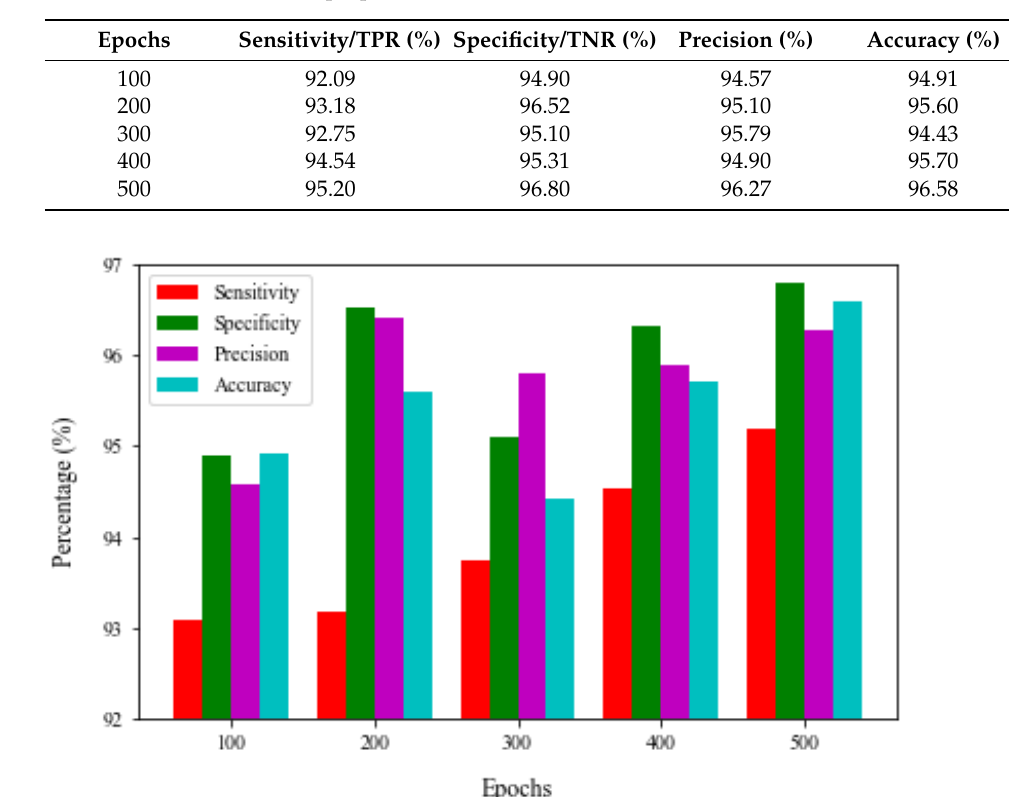
Figure 7. Proposed Conv-LSTM model outcome under varying epochs.